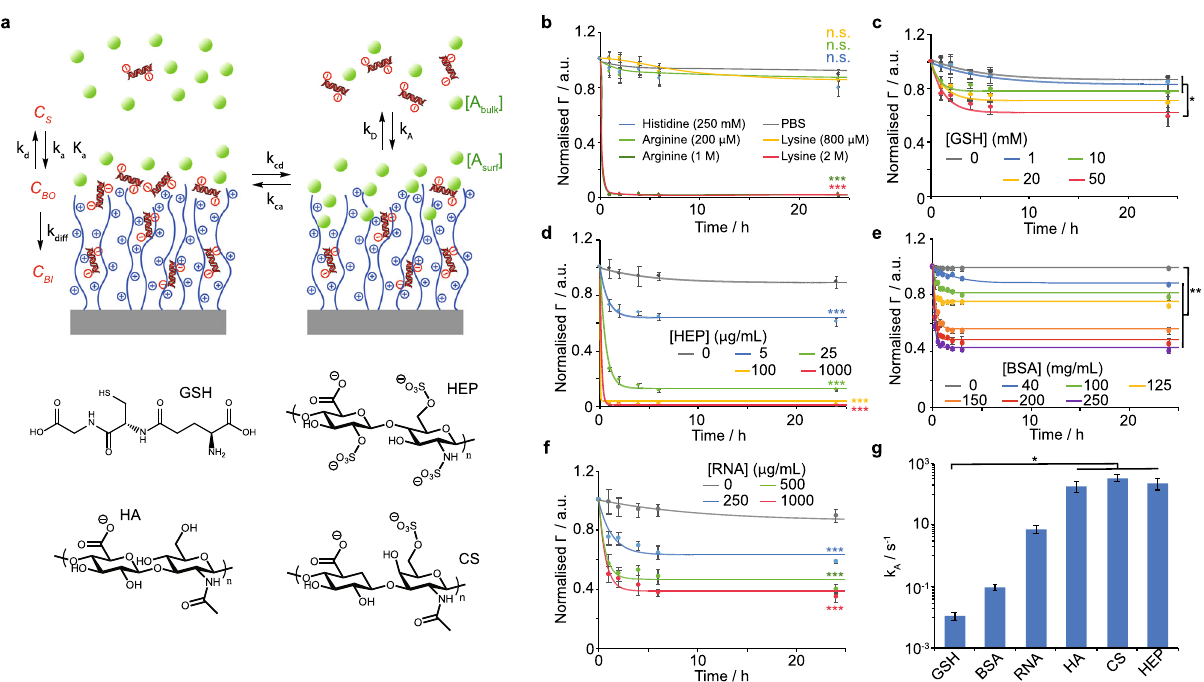
Fig. 3 Competitive binding regulates RNA exchange in physiological conditions. a Model of competitive binding with siRNA in fi ltrated within polymer brushes. b – f Release pro fi les of cy-5 tagged siRNA from PDMAEMA brush grafted silica microparticles in the presence of various amino acids ( b ; lines are only intended as guide for the eye), glutathione ( c ), heparin ( d ), BSA ( e ) and RNA ( f ), as a function of competitor concentration. Lines shown in ( c – f ) are fi t lines based on Eq. 1. g Measured adsorption rate constant ( k A ) of different competitors extracted from Supplementary Equation 11. a.u., arbitrary units. Data are presented as mean values. Error bars are standard errors from triplicate experiments. n.s., not signi fi cant; * p < 0.05; ** p < 0.01; *** p < 0.001 (ANOVA); with respect to PBS ( b ) and 0 mg/mL ( d – f ), unless indicated